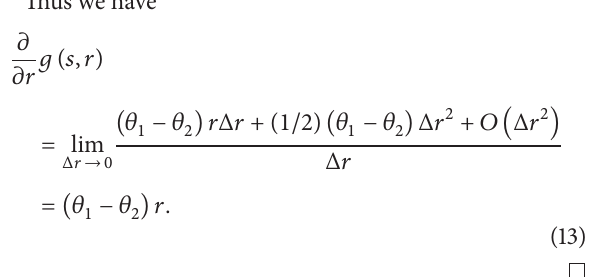
Figure 8: Deriving 𝜕𝑔/𝜕𝑟 as the arclength of the circular segment.